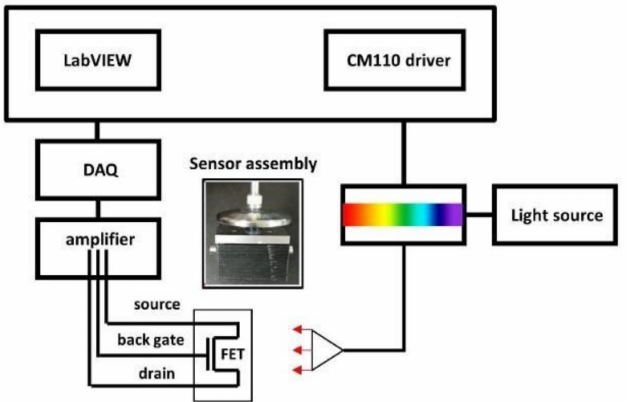
Figure 1. The block diagram and photographs of the measurement system.